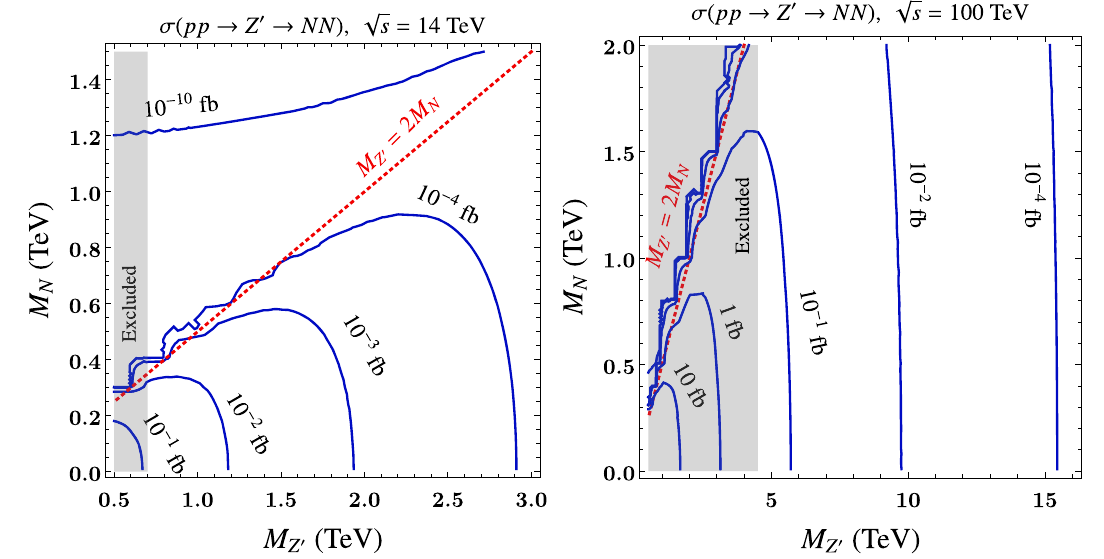
√ s = 14 TeV (left) and g (cid:2) = 0 . 1 and